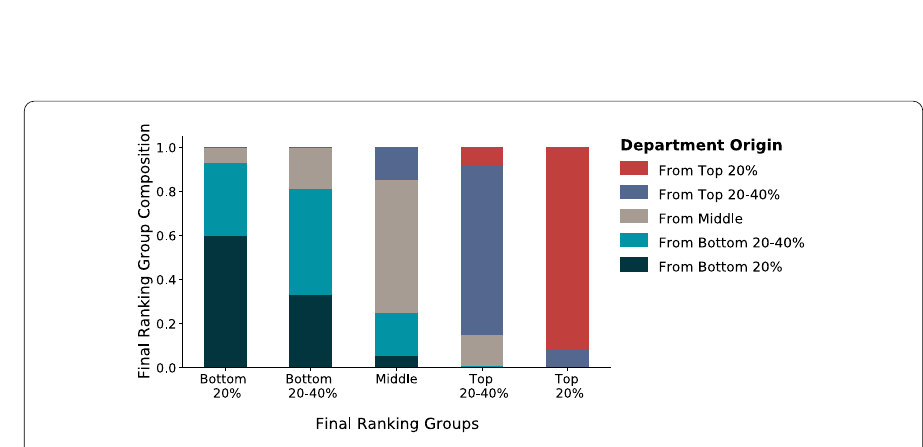
Figure S11 Final ranking group composition of History departments. Rank mobility results derived from the best fitting Faculty production model with egalitarian initialization, with β = 1.0 and p = 0.009. The composition of departments’ origin is traced and averaged over 50 hiring simulated